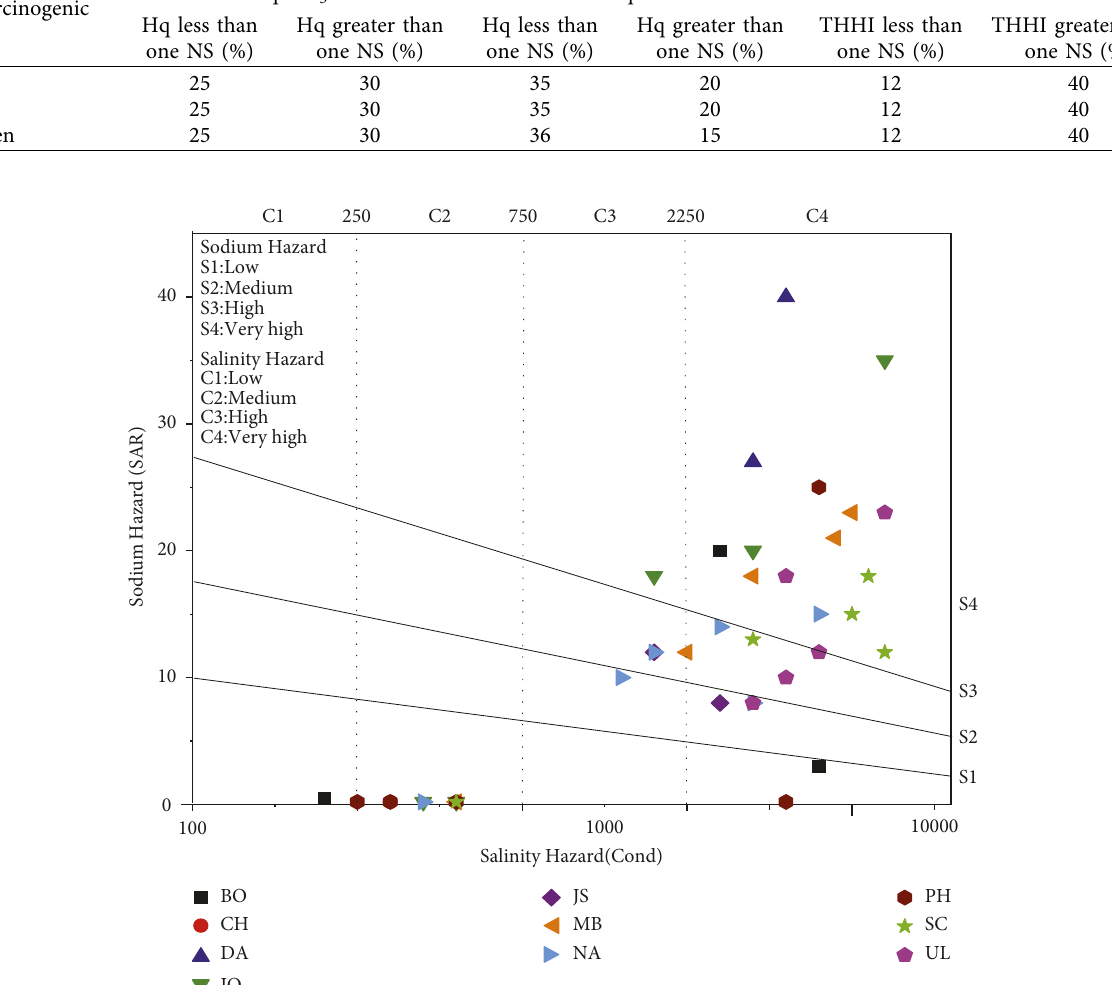
Figure 4: USSL salinity